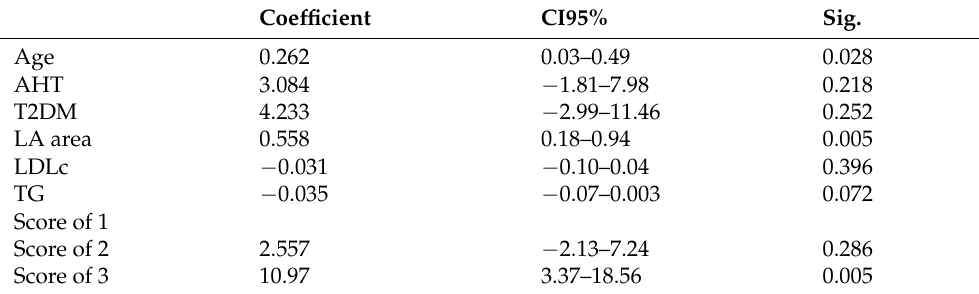
Table 2. Multivariable linear regression analysis: low-voltage area as dependent variable.